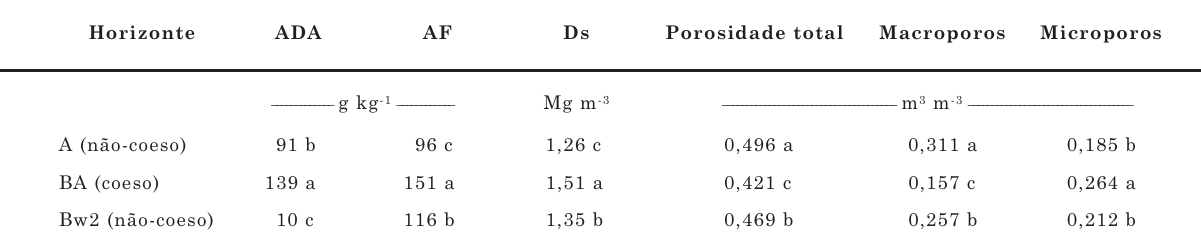
Quadro 2. Argila dispersa em água (ADA), argila fina (AF), densidade do solo (Ds), porosidade total, macroporos e microporos nos horizontes A, BA e Bw2 de um Latossolo Amarelo de São Miguel dos